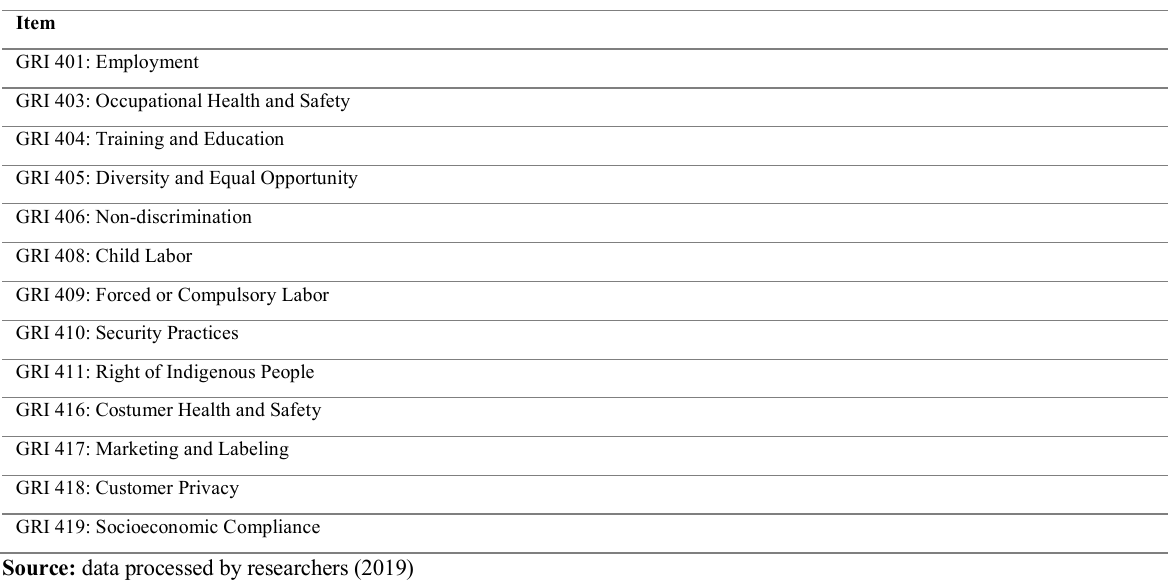
Table 7. Social Item for Faculty SR